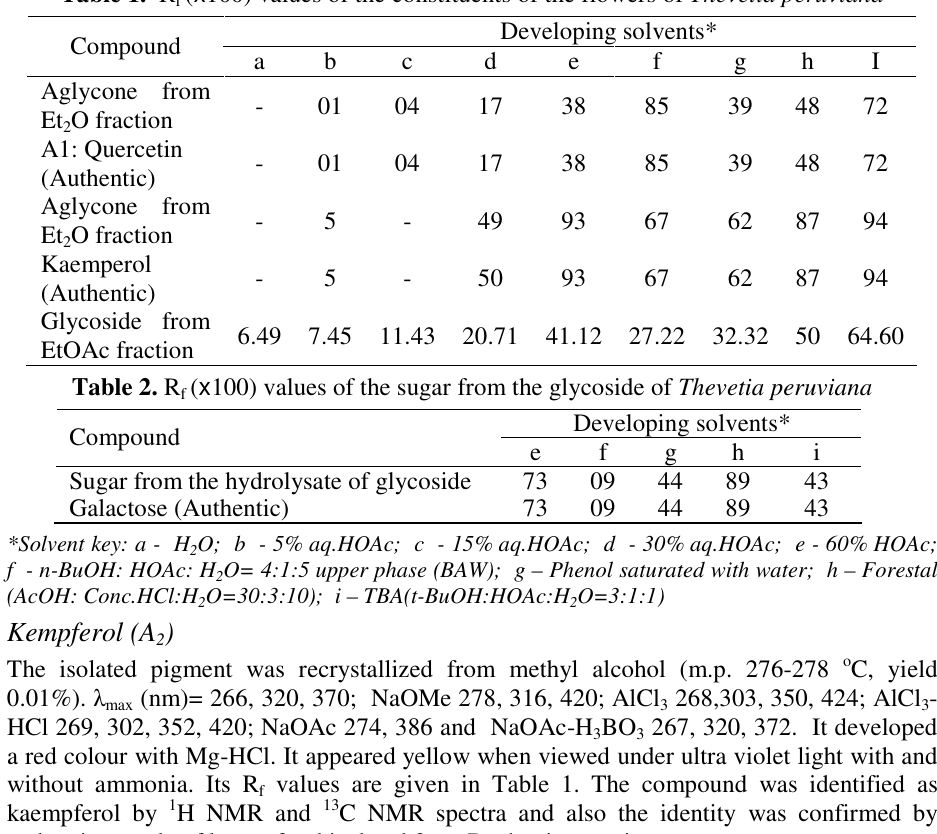
Table 1. R ( x 100) values of the constituents of the flowers of Thevetia peruviana f Compound